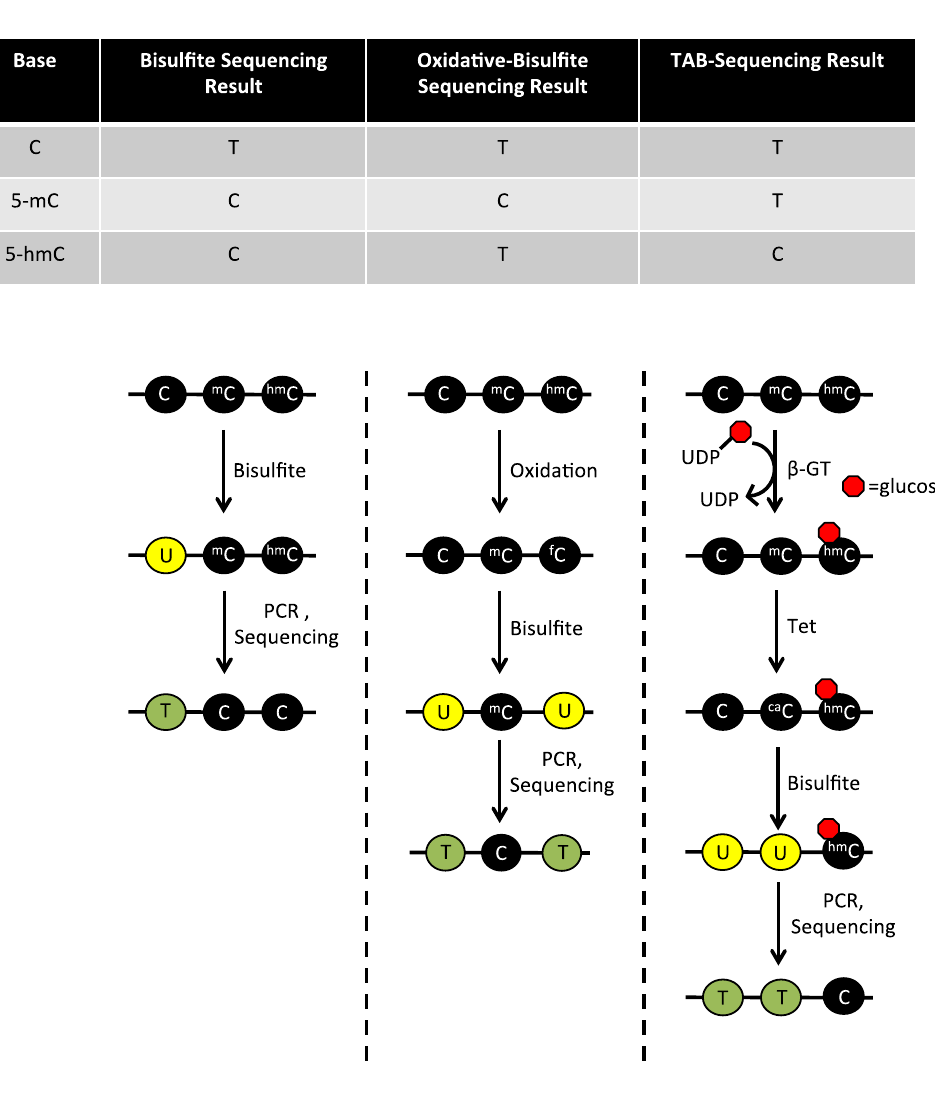
Figure 4. Techniques used to distinguish modified cytosine species at single base resolution. ( A ) In traditional bisulfite sequencing, bisulfite converts cytosine to uracil (yellow circles), which is then sequenced as a thymine (green circles), whereas 5-mC and 5-hmC remain unchanged. ( B ) In oxidative bisulfite sequencing, an additional oxidative step is included before bisulfite treatment that converts 5-hmC to 5-fC. 5-fC is then converted to uracil on bisulfite treatment so that both cytosine and 5-hmC are read as thymines during sequencing of oxidative-bisulfite treated DNA. ( C ) Finally, in Tet-assisted bisulfite sequencing (TAB-Seq), all 5-hmC residues are conjugated to glucose (small red circle). This protects them from oxidation during treatment with Tet, which converts all modified cytosines, except 5-hmC, to 5-caC. On bisulfite treatment, only glucose conjugated 5-hmC residues are protected from deamination and are read as cytosines during